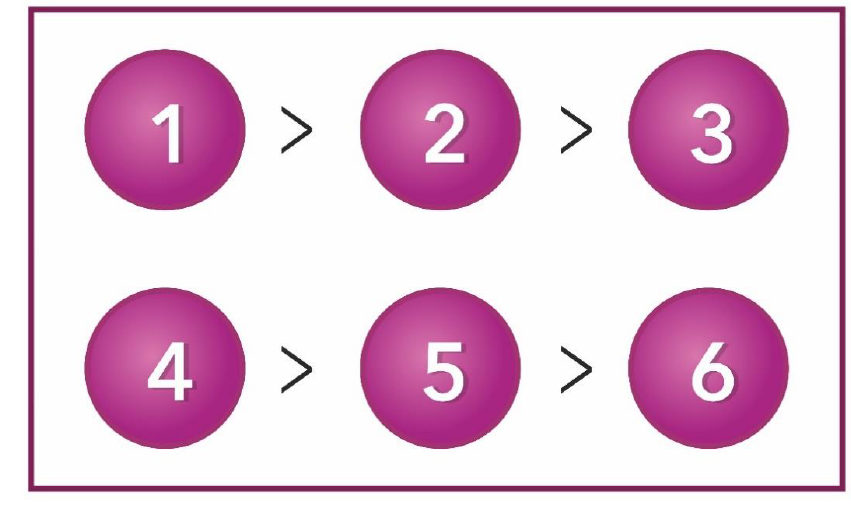
Figure 2. The pattern of UV exposure.